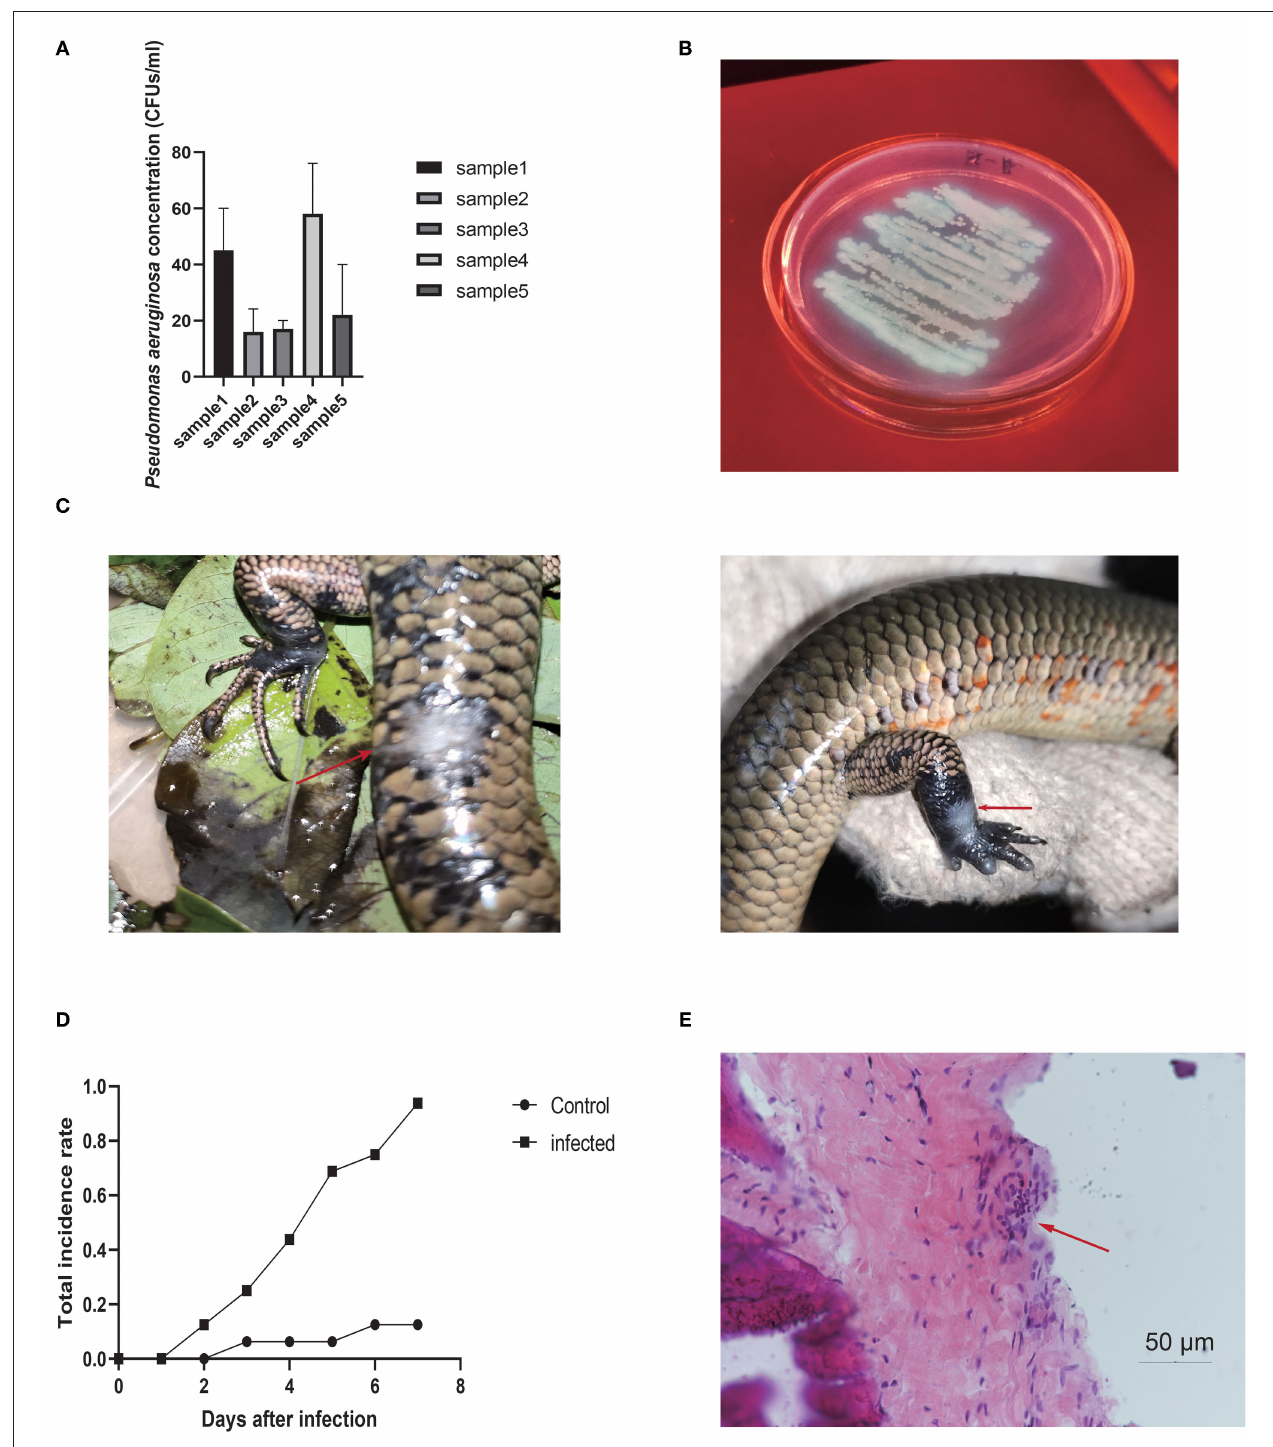
FIGURE 1 | (A) Pseudomonas aeruginosa CFUs isolated from five groups of water samples in breeding enclosures. (B) Colonies of P. aeruginosa isolated from water samples on agar plates. (C) Pseudomonas aeruginosa -infected wounds in Chinese skinks. Arrows point to ulcers. (D) Infection rate under P. aeruginosa strain compared to control group, with obvious differences between groups. (E) Pseudomonas aeruginosa -infected wound under the microscope. Arrows point to inflammatory changes.